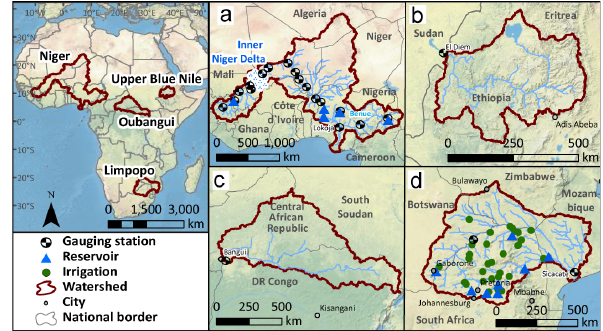
Fig. 1. Map of the four modelled basins: Niger (a) , Upper Blue Nile (b) , Oubangui (c) , Limpopo (d)